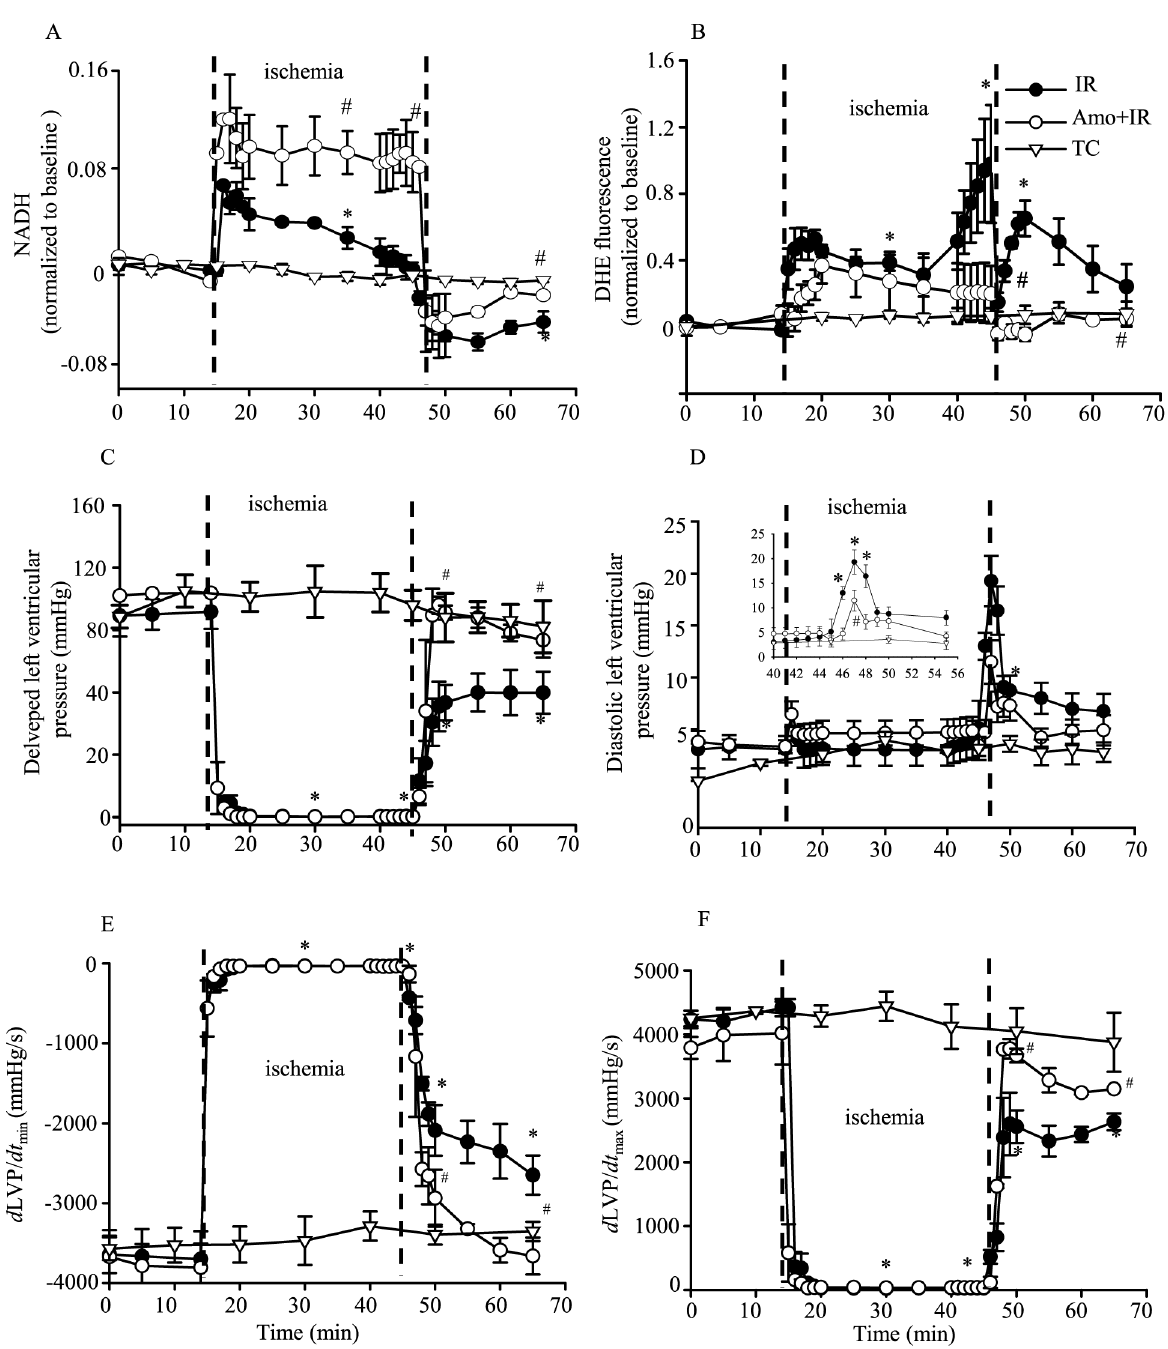
Figure 4. NADH autofluorescence (afu) (A) was higher and DHE fluorescence intensity (O 2 2 N emission) (B) was lower during ischemia and reperfusion after amobarbital (Amo) treatment compared to IR alone. DHE and NADH were recorded online in isolated hearts at the LV free wall. n 5 6 hearts/group/fluorescence measure. Cardiac contractile and relaxant function: developed LVP ( C ), diastolic LVP ( D ), d LVP/ dt min ( E ) and d LVP/ dt max ( F ) were improved on reperfusion after amobarbital (Amo) treatment during ischemia. Inset in D shows detailed changes in diastolic LVP during late ischemia and early reperfusion. n 5 9 hearts/group/functional measure. All values are means ¡ SEM. TC, time control; IR, ischemia and reperfusion. P , 0.05: *IR vs. TC; # Amo + IR vs. IR.